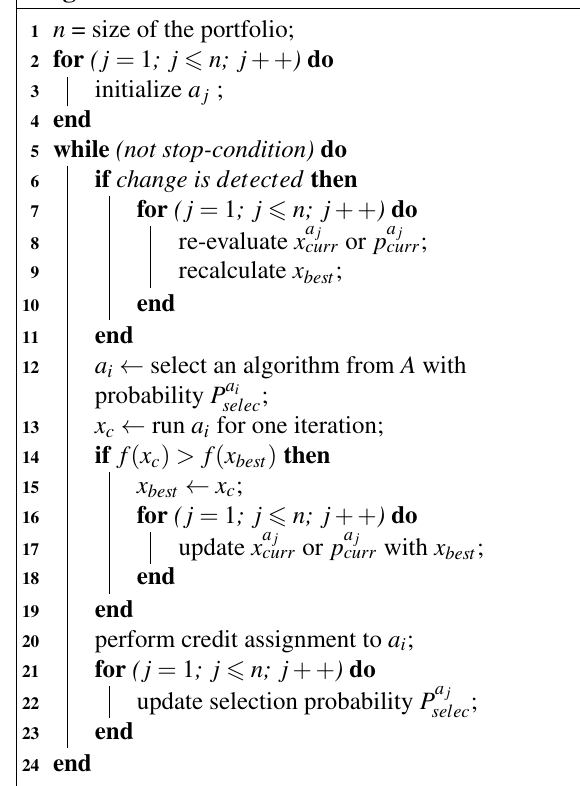
Algorithm 1: Portfolio Scheme